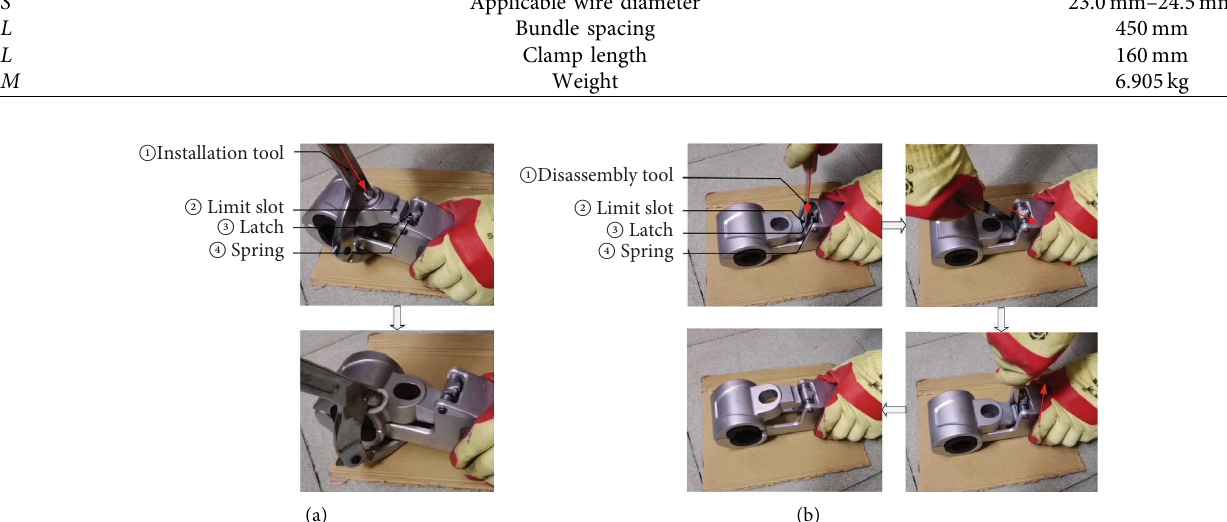
Figure 11: Installation and disassembly process of the new quad-bundle spacer damper clamp: (a) installation process and (b) disassembly